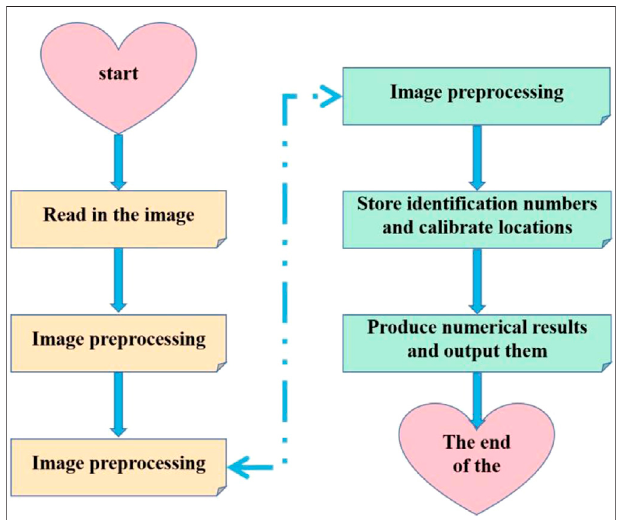
FIGURE 3 | Character recognition algorithm fl ow.